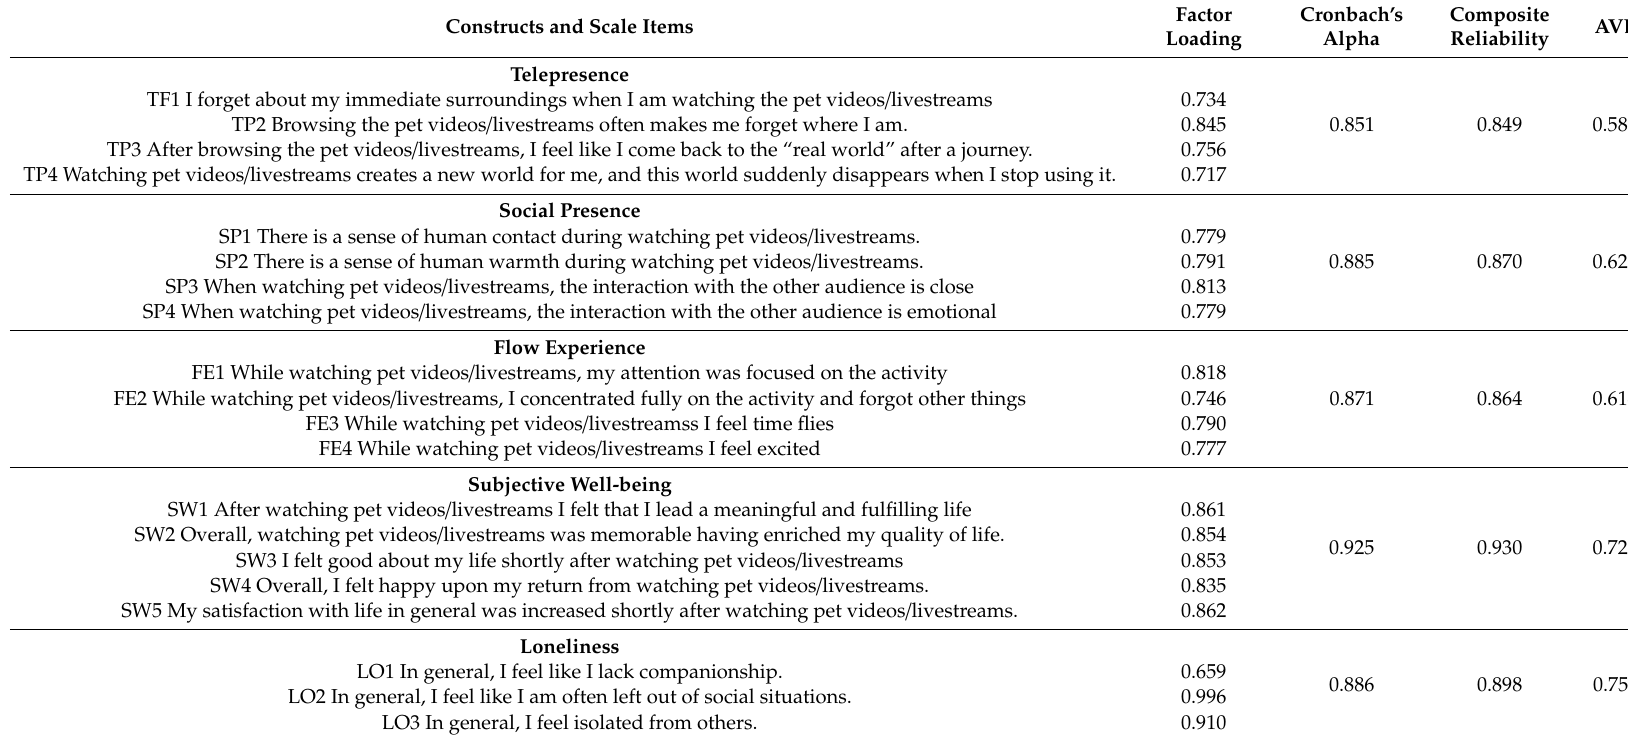
Table 3. Reliability and convergent validity of the